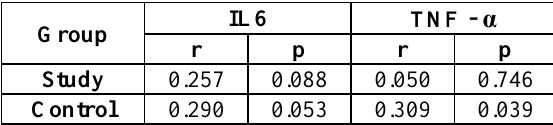
Table 3: Relation between